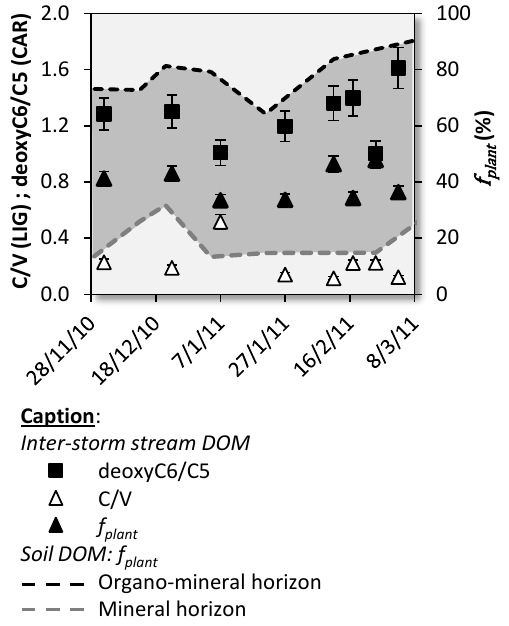
Figure 3. Variation in the molecular composition of inter-storm DOM in the stream (C / V, deoxyC6 / C5 and f plant ). The grey area is delimited by the f plant in soil DOM from the organomineral and mineral horizons. Dates are given in